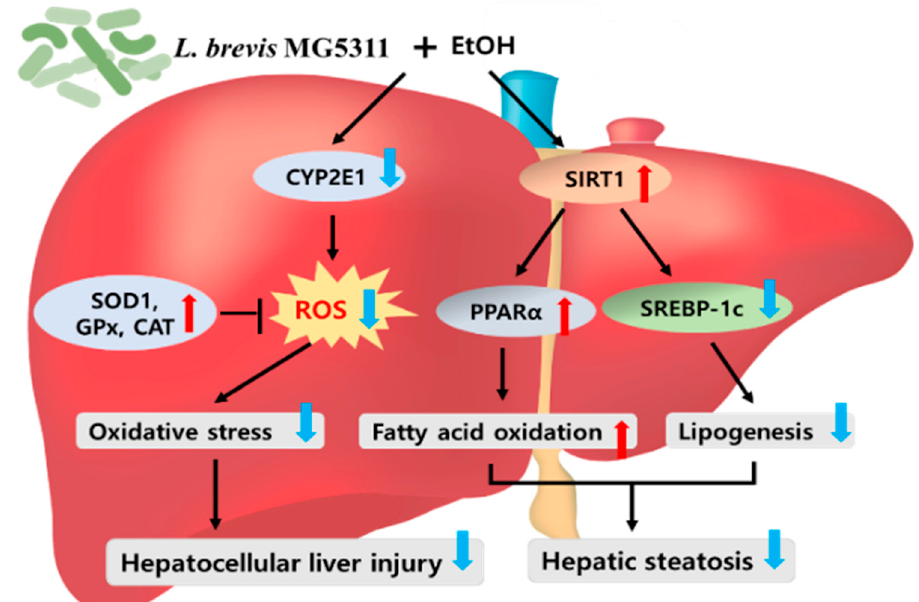
Figure 8. L. brevis MG5311 exerts hepatoprotective effects by regulating hepatic oxidative stress and lipid metabolism. CYP2E1, Cytochrome P450 2E1; SIRT1, Sirtuin 1; SOD1, superoxide dismutase 1;